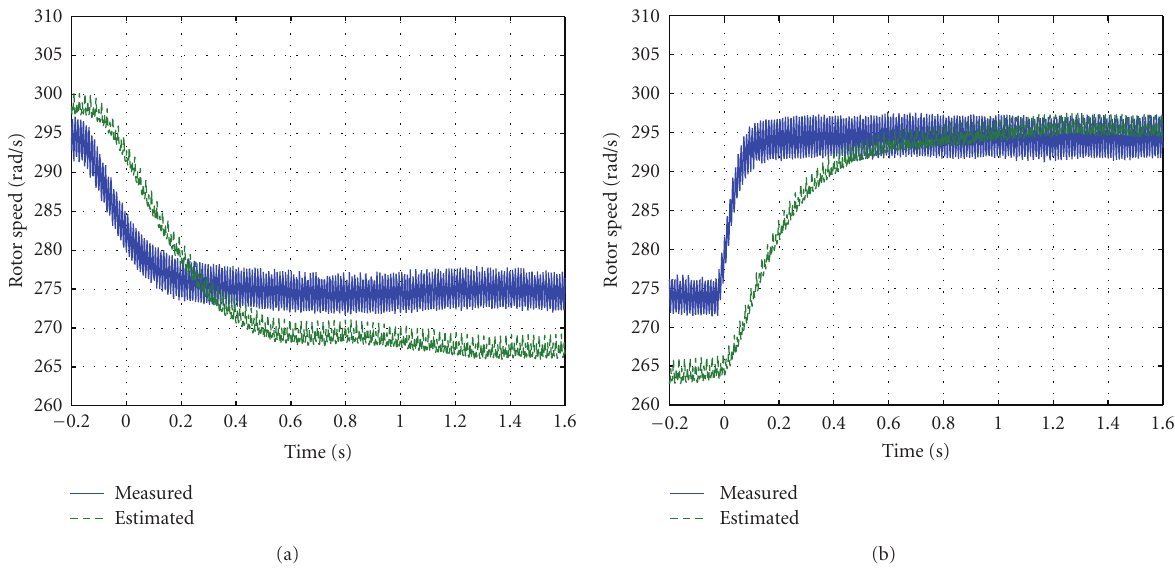
Figure 16: Measured and estimated rotor speed ω r (experimental results): (a) when a mechanical load is applied to SPIM shaft, (b) when a mechanical load is removed of the SPIM